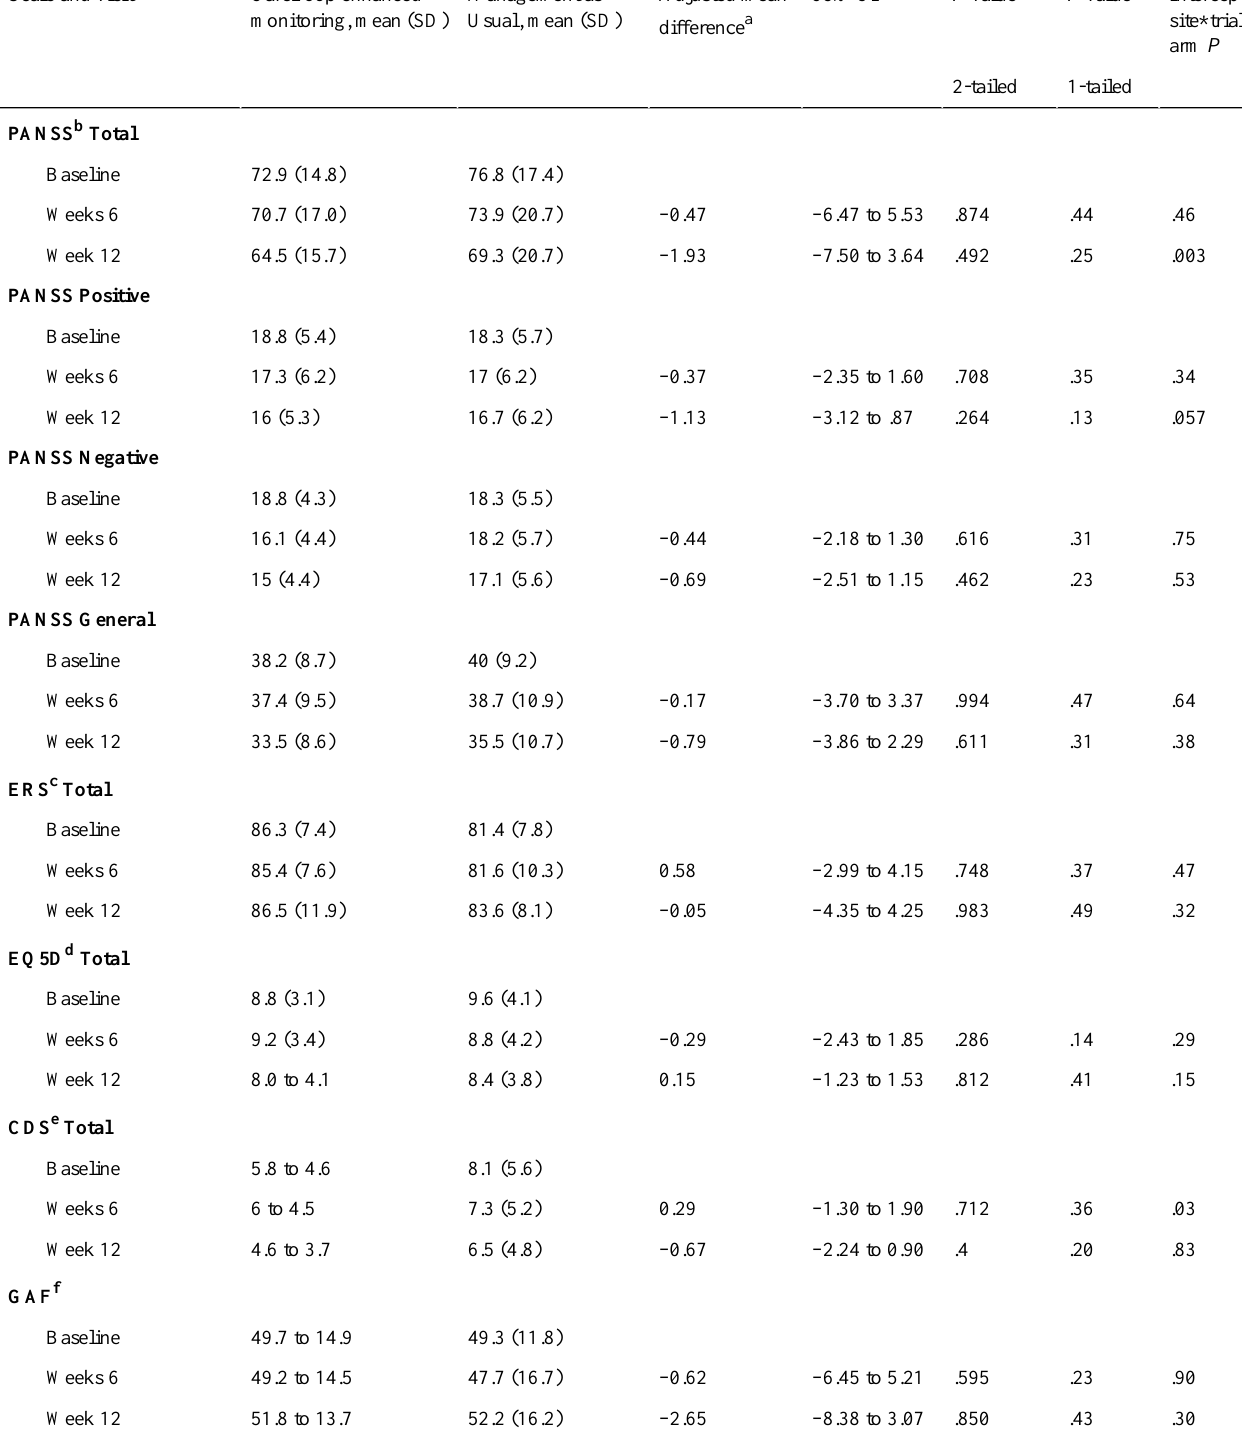
Table 3. Clinical Measures at baseline, 6, and 12 weeks by allocation